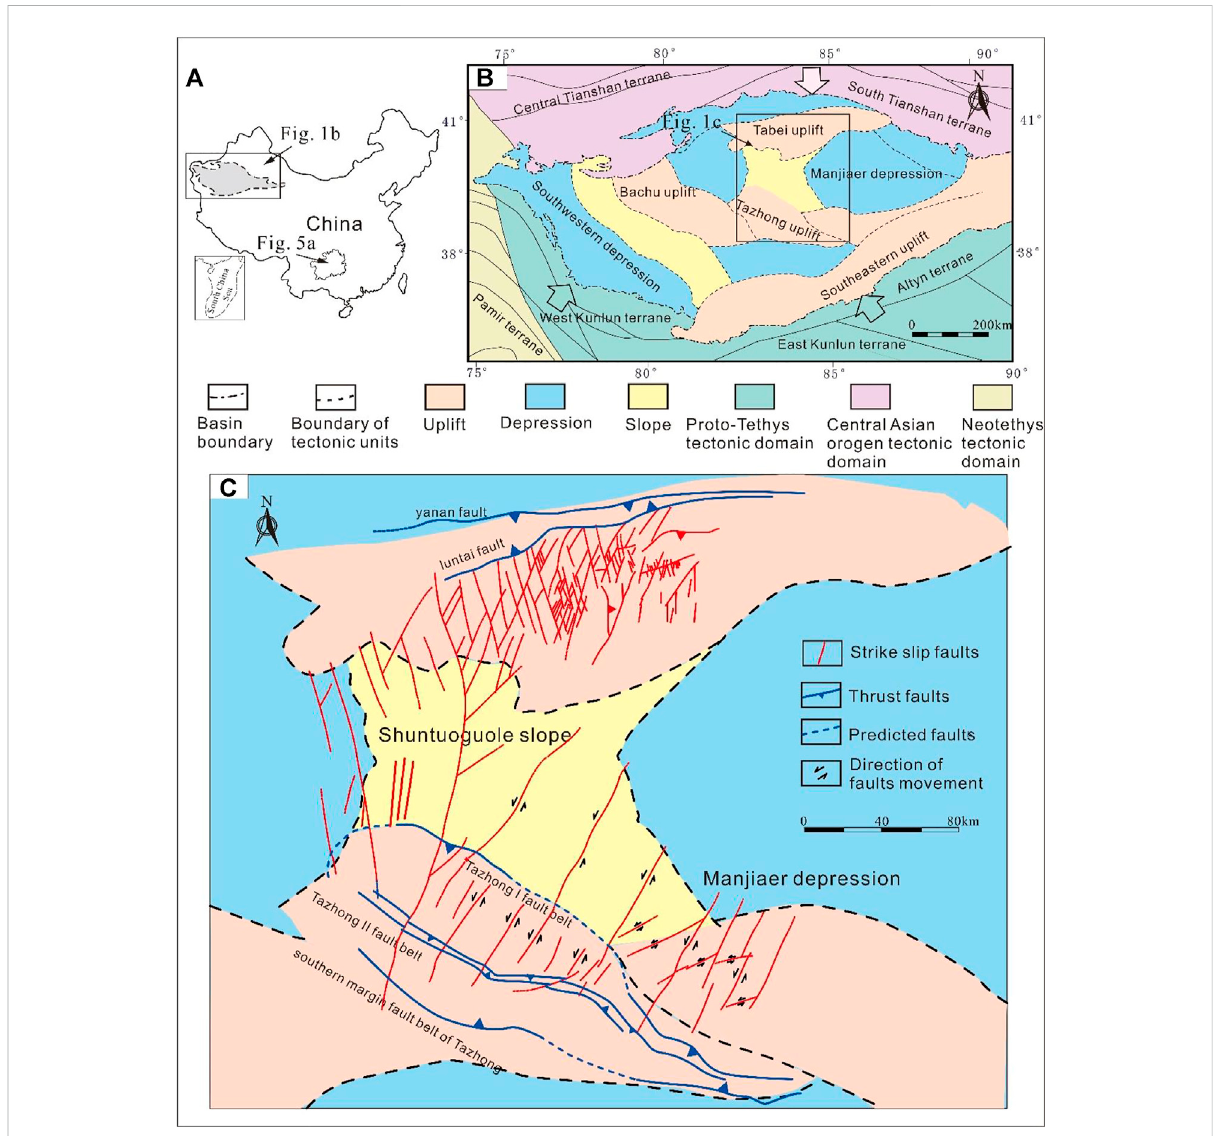
FIGURE 1 Distribution of strike-slip faults in Tarim Basin; (A) location of the Tarim Basin and Guizhou Province; (B) map showing the distribution and structural background of the Tarim Basin; (C) detailed map of distribution of the strike-slip fault belts in the eastern part of the Tarim Basin based on the interpretation of seismic